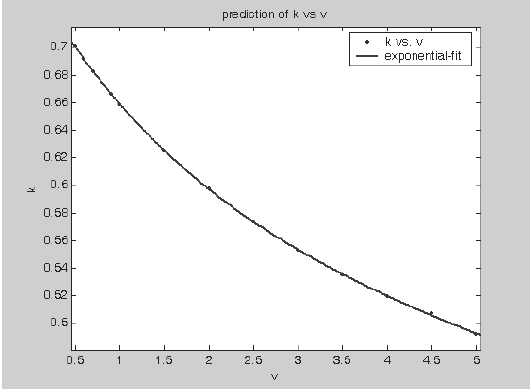
Figure 2 – Graph of prediction of k vs. .